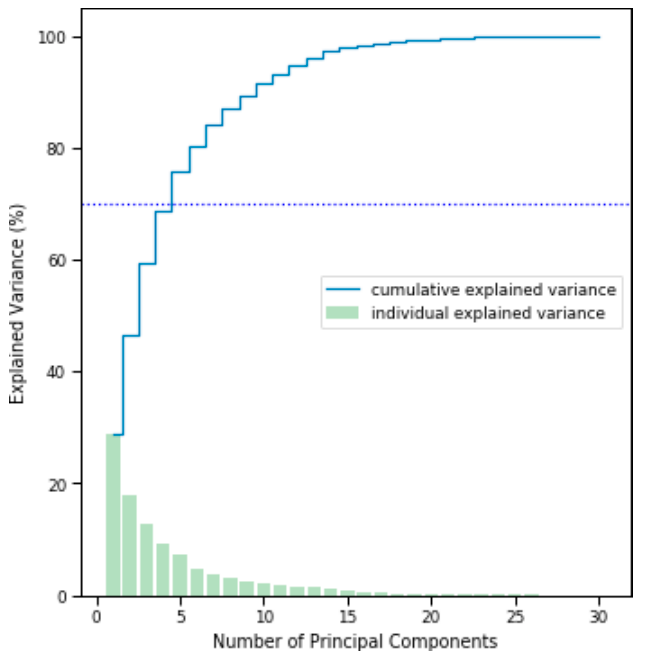
Figure 3. Cumulative variance plot showing that 80.4% of the variance can be explained by the first six principal components.